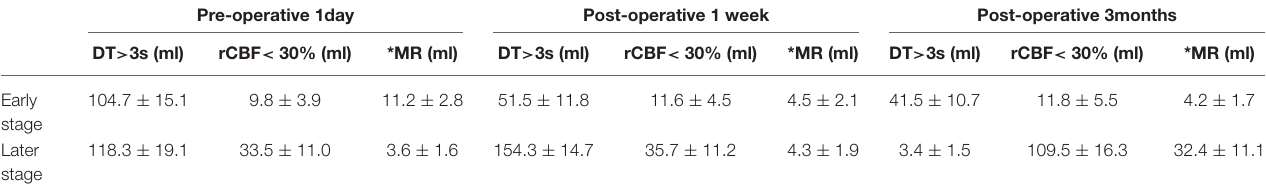
TABLE 3 | WB-CTP showing hemodynamic characteristics in ischemic MMD patients of different Suzuki stages (in early stage and later stage) at different time points. Pre-operative 1day Post-operative 1 week Post-operative